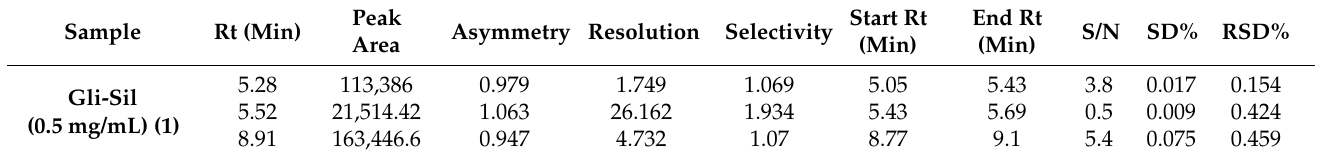
Table 5. The Rt calculated for all 6 injected samples, characteristic of a Gli and Sil concentration of 0.5